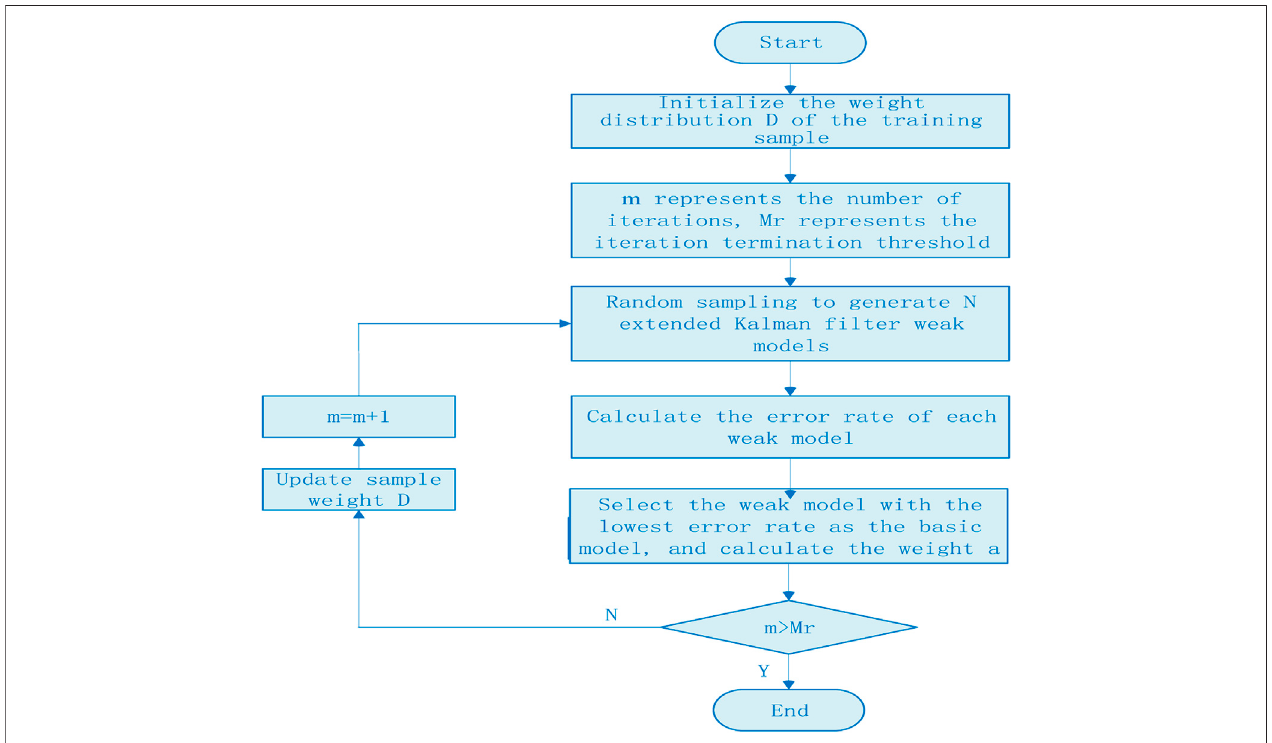
FIGURE 1 | The fl ow chart of Adaboost training